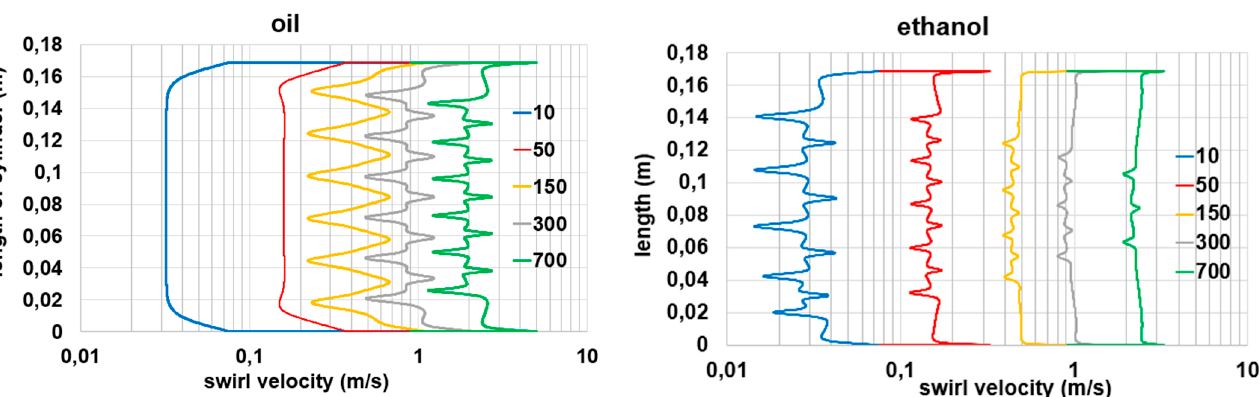
It can be seen from Table 4 that the vortex structures of the swirl velocity for oil and ethanol coincide with the experiment. Figure 9 evaluates the swirl velocity profile in the logarithmic coordinates depending on the liquid (oil or ethanol) and the speed of the rotor in the middle of the gap. The number of strips in the experiment can be determined by the number of peaks.